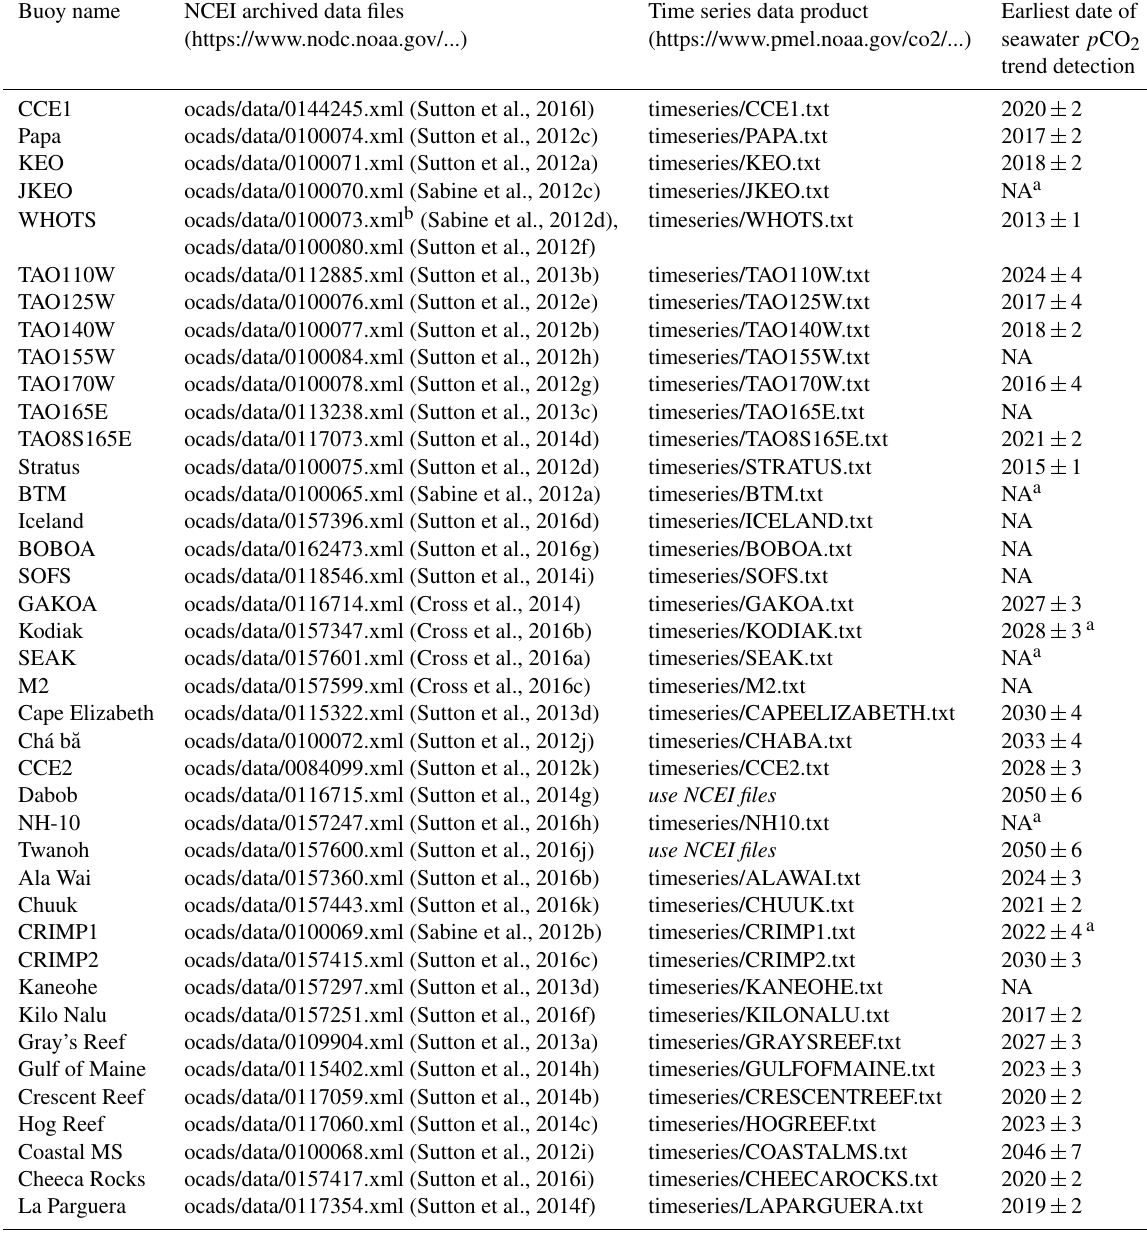
Table 2. Data access to deployment-level archived data files at NCEI and the time series data product for each moored buoy location. The earliest date of seawater p CO 2 trend detection is based on time series product data and calculated by adding the ToE estimate (Eqs. 1–4) to the time series start year (Table 1). The uncertainty presented here (in years) is the result of Eqs. (2)–(3), which is based on ToE ts and does not include any additional uncertainty due to the decadal estimate from Eq. (4). NA denotes sites with less than 3 years of observations where interannual variability is likely not represented in a time series, and ToE is consequently not